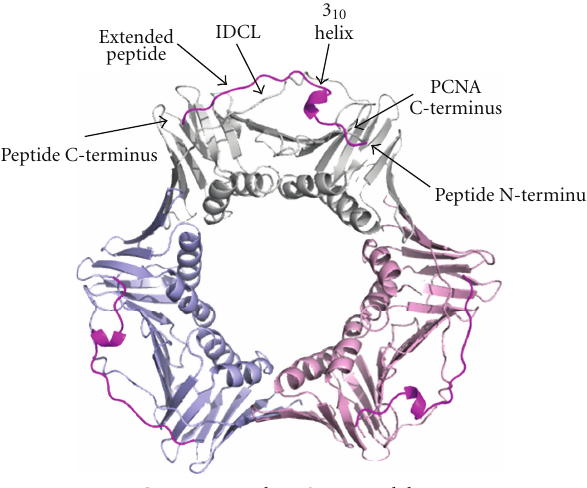
Figure 1: Human PCNA in complex with p21 peptide (1AXC) [2]. PCNA is a trimeric molecule, with each monomer containing a PIP-box binding site and located between the C-terminus of the protein and the interdomain connector loop (IDCL). The human PCNA in complex with p21 shows the classic mode of interaction, with the conserved glutamine of the PIP-box motif interacting both directly and via solvent molecules with the clamp surface. The turn of 3 10 helix and the immediately C-terminal region insert the hydrophobic section of the motif into the hydrophobic cleft on the PCNA surface. The extended peptide forms an interaction with the IDCL. Each PCNA monomer is coloured separately with the p21 peptide in magenta. Key features are labelled. Also shown is the PIP- box consensus motif, where a indicates a small hydrophobic residue, h is an aromatic residue, and x is any amino acid [1]. Figures, unless otherwise stated, were produced using PyMol